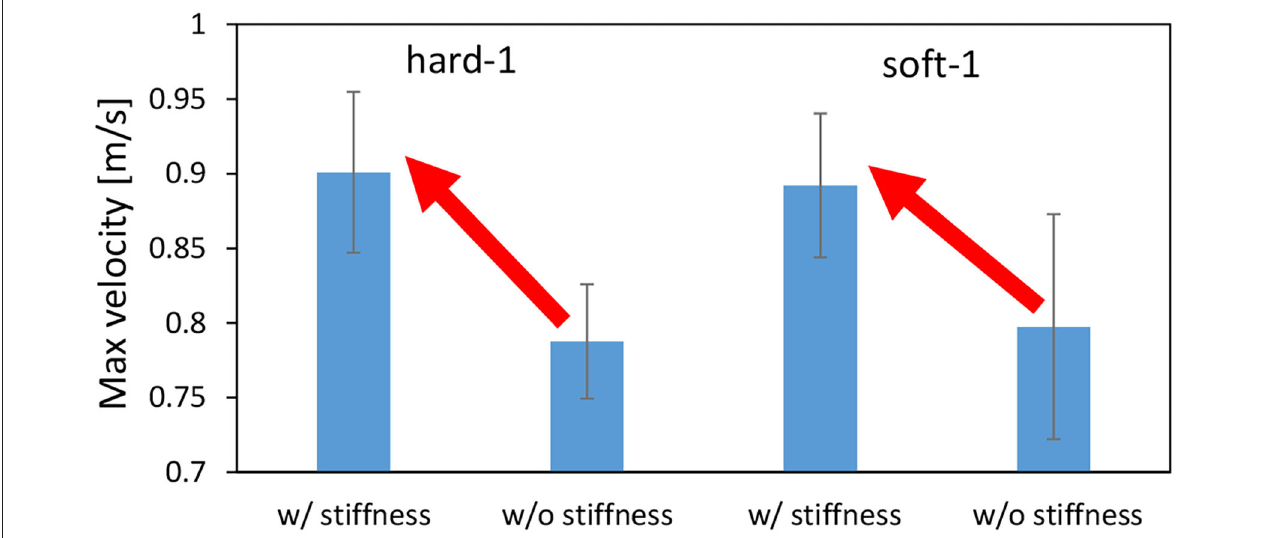
FIGURE 12 | Actual robot experiment: the average and SD of the maximum velocity of the end effector when conducting experiments of dynamic manipulation of hard-1 and